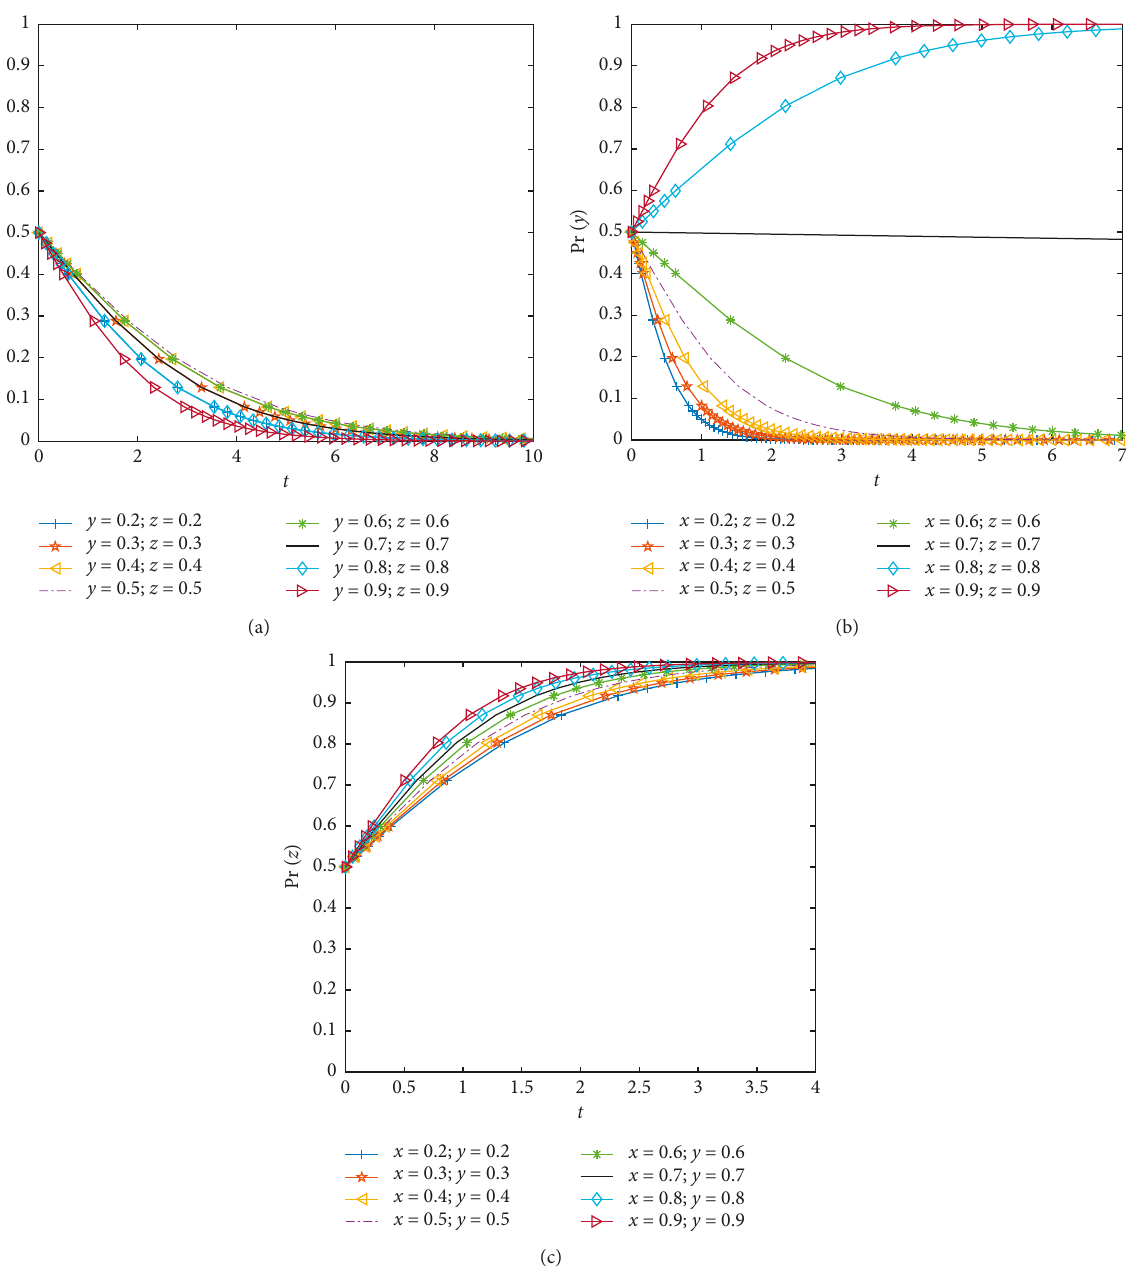
Figure 1: (a) Evolution curve of x when y and z change. (b) Evolution curve of y when x and z change. (c) Evolution curve of z when x and y